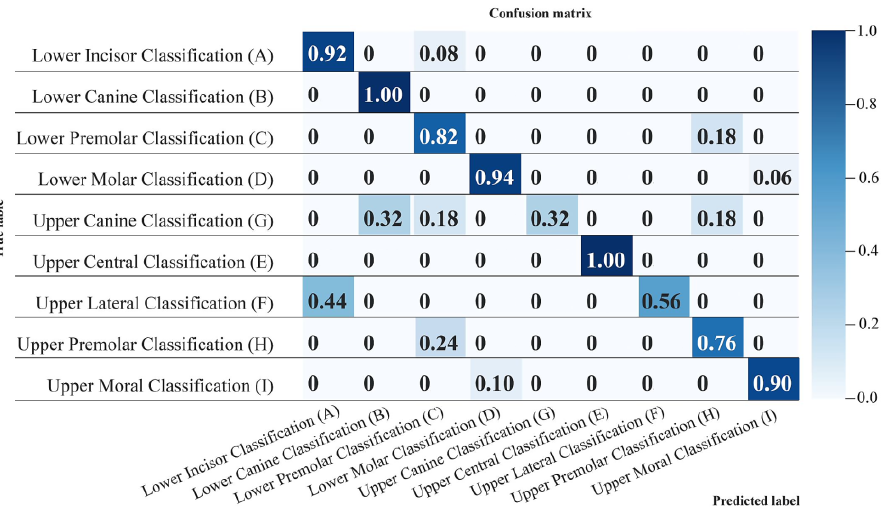
Figure 4. Comparison of deep learning configurations with different parameter combinations, with and without augmentation. Configuration 5 achieved the highest accuracy.